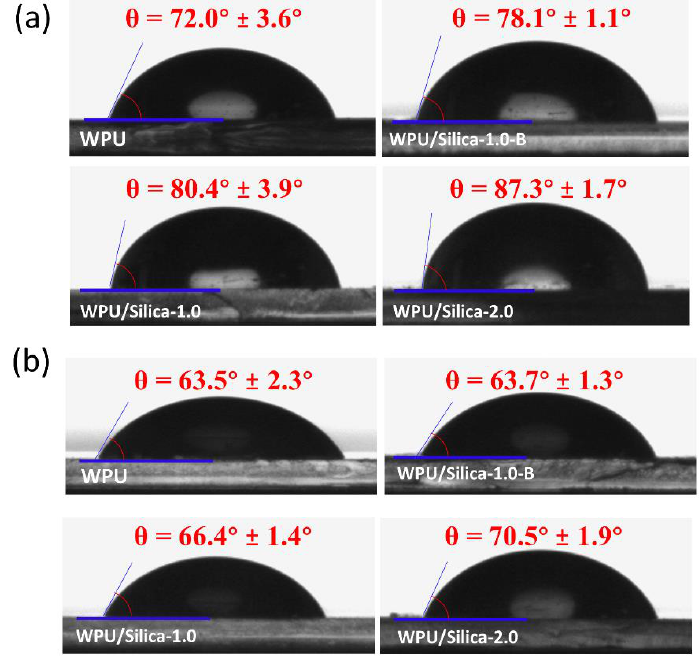
Figure 6. Contact angle of WPU and WPU/Silica coatings: ( a ) water and ( b ) glycol. Table 1. Surface free energy of WPU and WPU/Silica coatings.